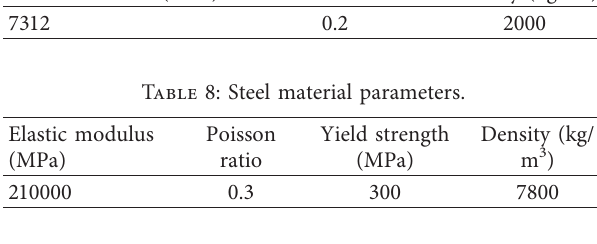
Table 7: Material parameters of cement mortar. Elastic modulus (MPa)